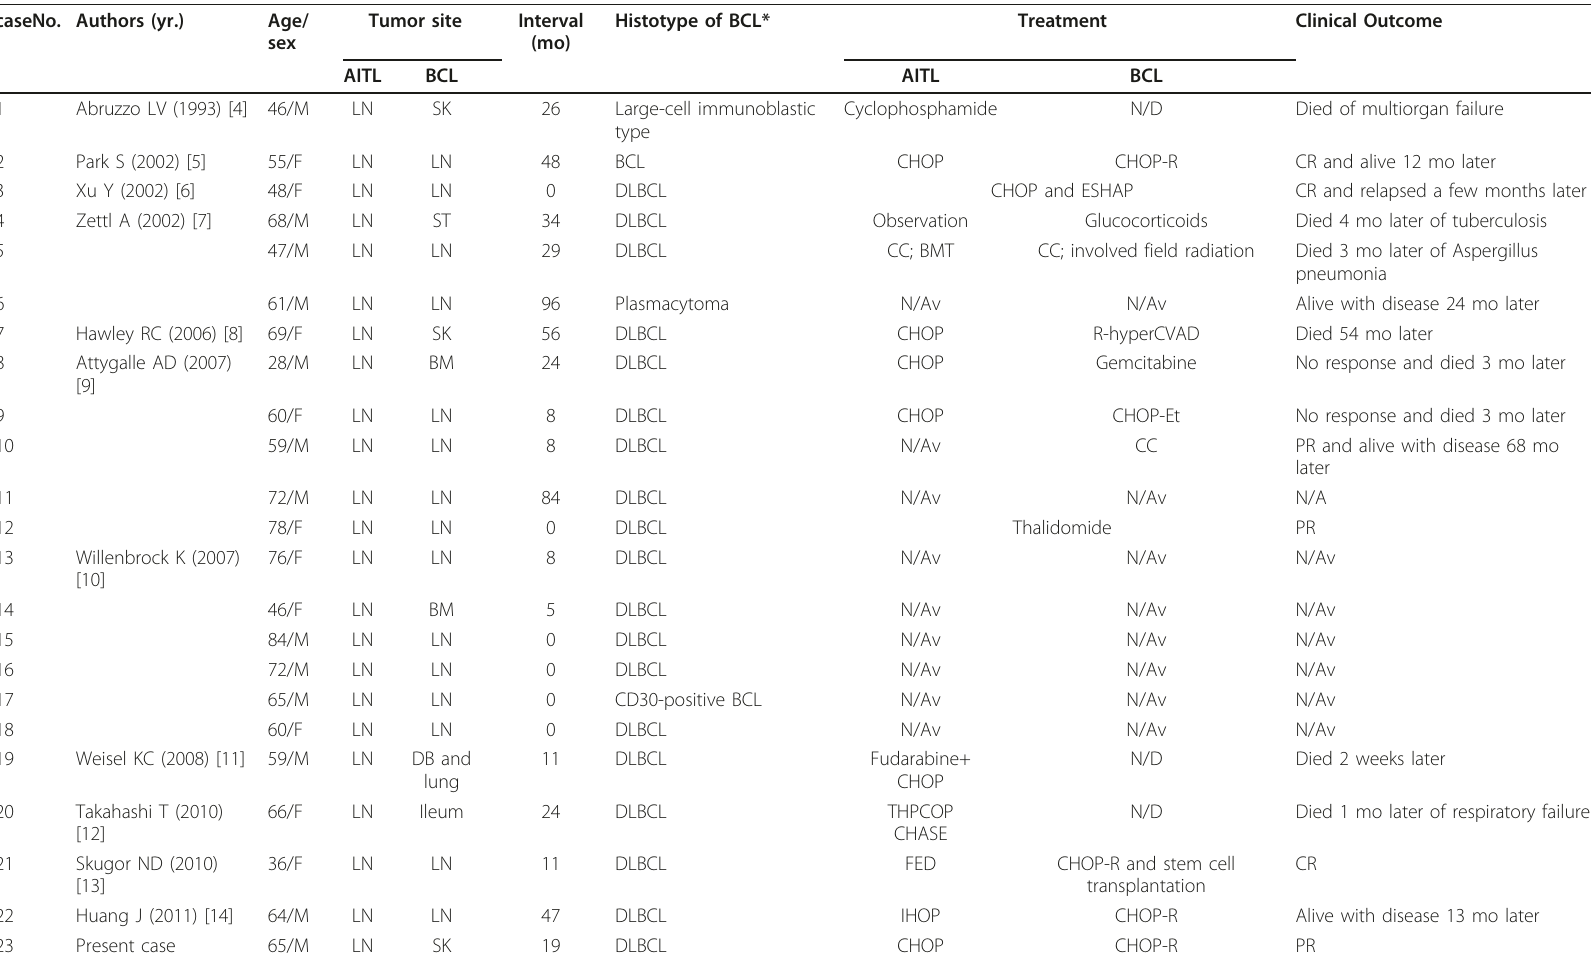
Table 1 Clinicopathological features of patients with AITL-developed secondary EBV-associated B cell lymphoma described in present and previous reports caseNo. Authors